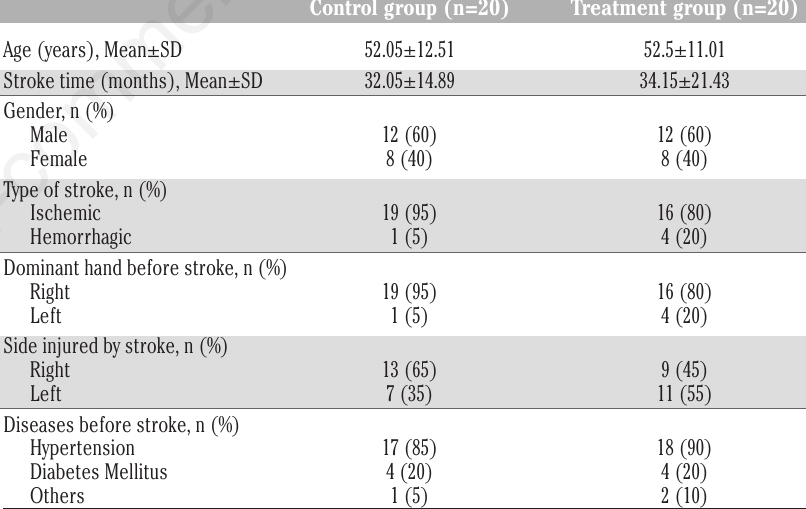
Table 1. Demographic characteristics.